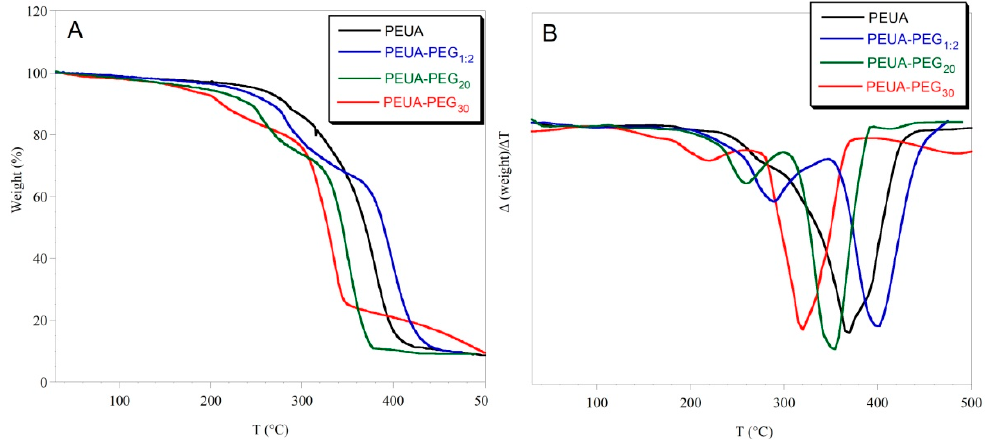
Figure 5. Thermogravimetric curves of PEUA, PEUA-PEG 1:2 , PEUA-PEG 20 , and PEUA-PEG 30 ( A ); first derivative ( ∆ (weight)/ ∆ T) of the thermogravimetric curves ( B ). The subscript 1:2 on PEUA:PEG 1:2 indicates the molar ratio employed during functionalization.